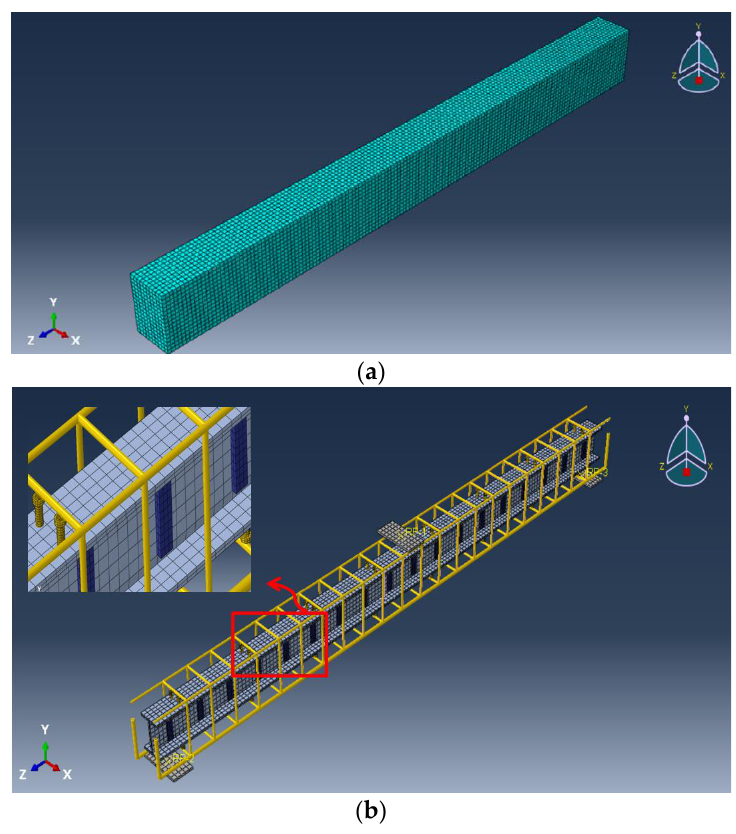
Figure 11. FE mesh shows the different components of the encased beams. ( a ) Mesh of the concrete beam. ( b ) Mesh of the studs, reinforcements, and GFRP